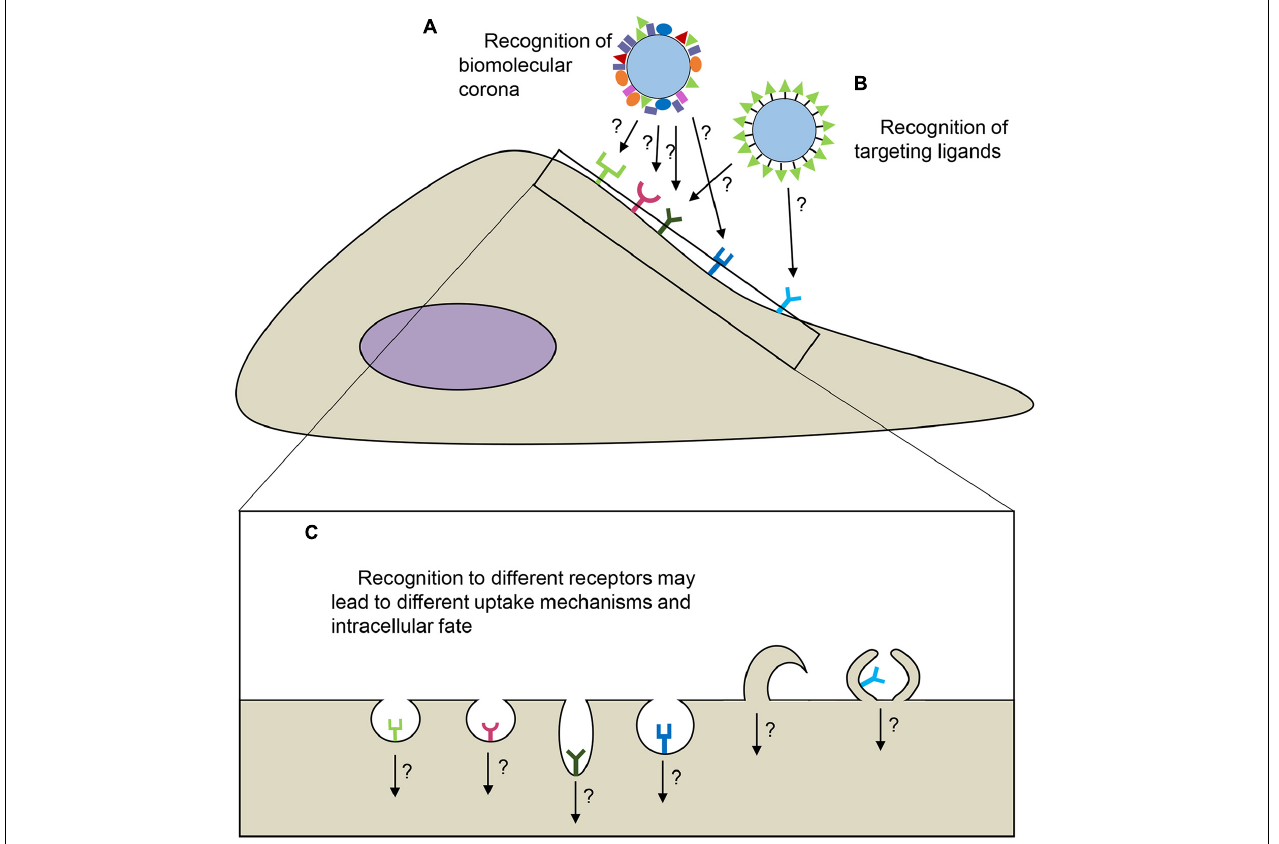
FIGURE 1 | Interactions of nanoparticles with cell receptors. Recognition can be achieved via the biomolecular corona (A) and/or targeting ligands (B) (Allen, 2002; Lara et al., 2017; Francia et al., 2019; Villaverde and Baeza, 2019). Depending on which receptors nanoparticles interact with, uptake mechanisms may differ (here illustrated by different shapes of the membrane invaginations and membrane protrusions), which could affect the intracellular fate of nanoparticles (C) .